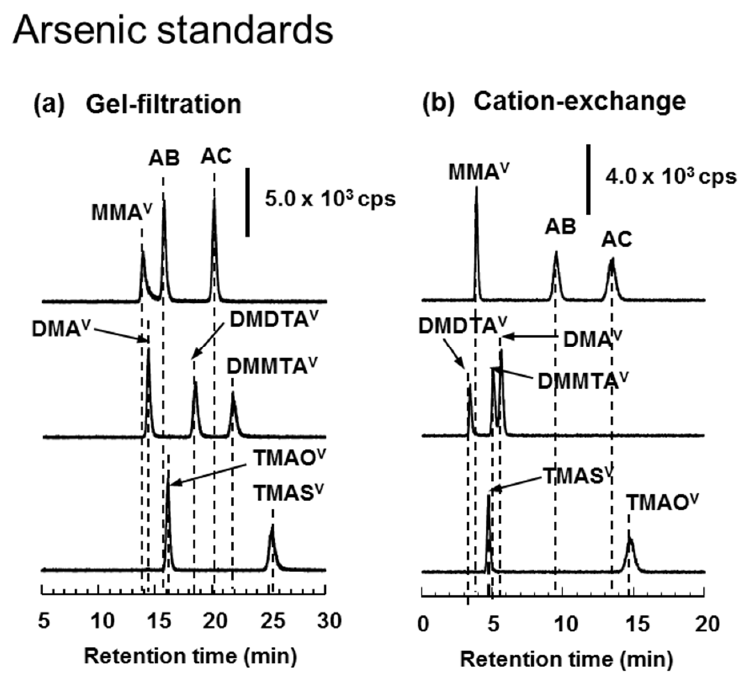
Figure 3. Elution profiles of arsenic standards by ( a ) gel filtration or ( b ) cation-exchange, as assayed by HPLC-ICP-MS. A 20- µ L sample was applied to the columns, which were eluted with the pre-filtered (0.22 µ m) mobile phase (see Table 1 for the elution conditions). The vertical bars indicate the level of detection (counts per second).